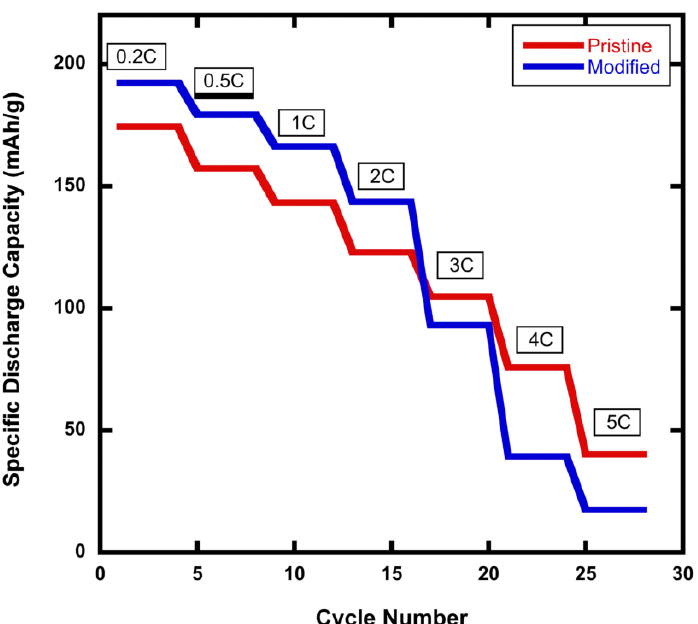
Figure 2. C-rate performance for batteries made with pristine NMC811 and modified rGO/NMC811 cathodes. The modified rGO/NMC811 battery has a higher specific discharge at C-rates < 3C. For C-rates > 3C, the pristine NMC811 battery experiences a higher specific discharge